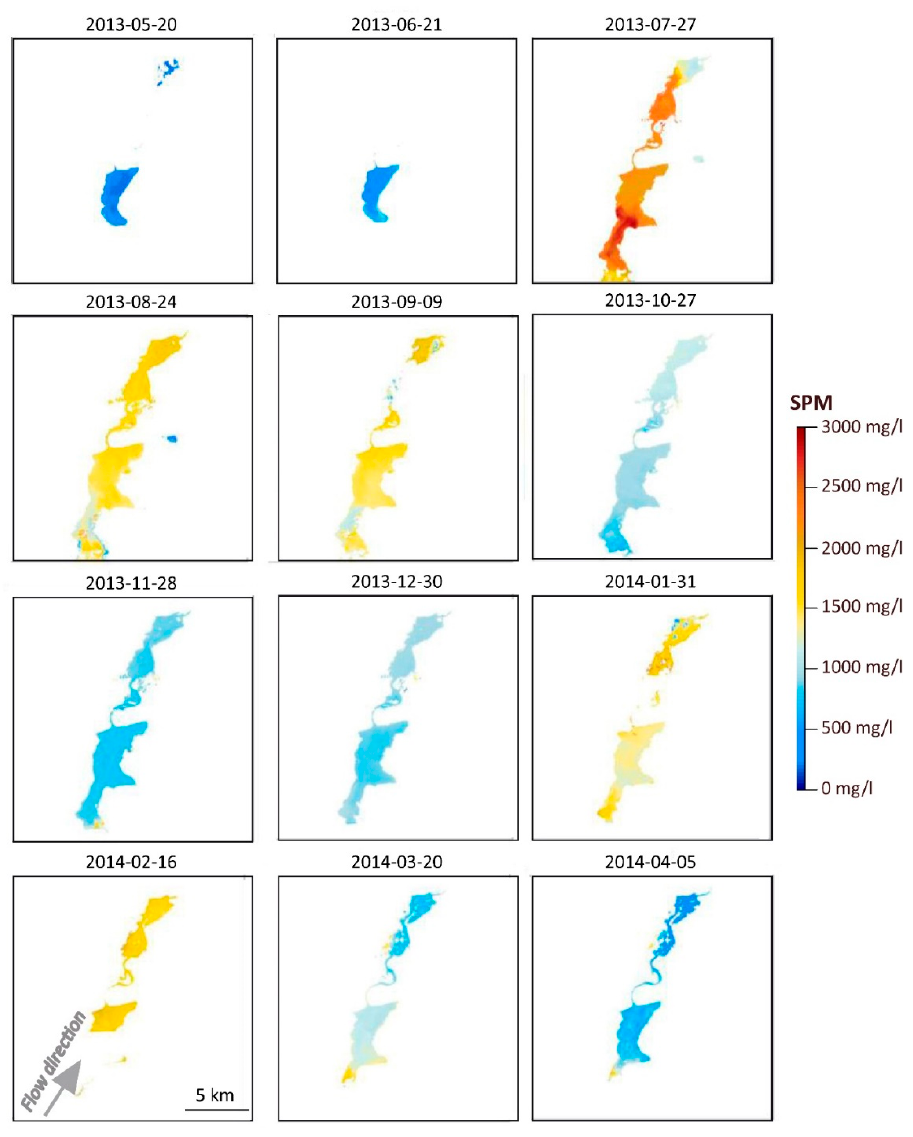
Figure 13. Spatial variability within the Gossi Lake during 2013–2014.